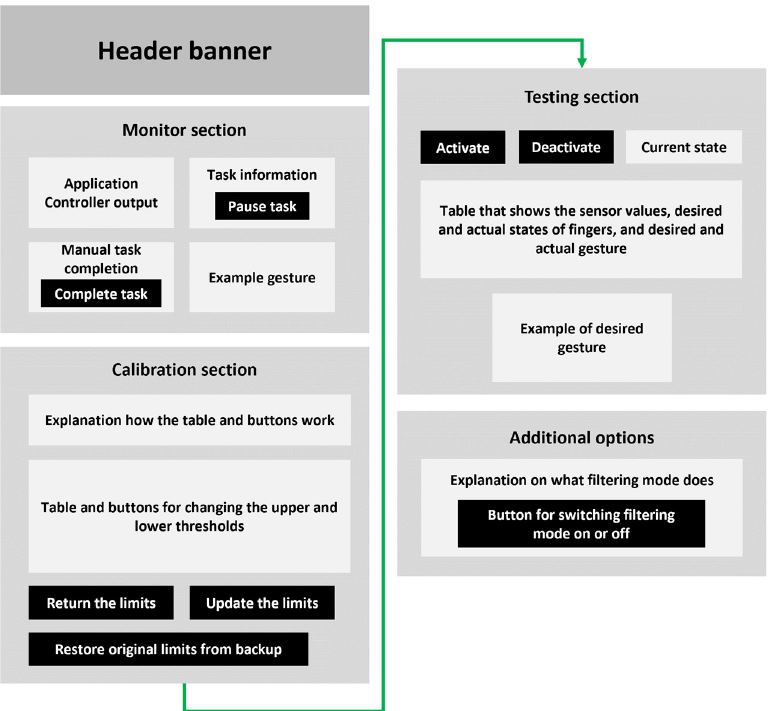
Figure 6. Wireframe of the UI developed for M2O2P component. The UI consists of three main sec- tions: monitor section for general information and task information, calibration section for calibrating the threshold values of the glove, and testing section for training and testing the gestures. Finally, additional options section holds a button to switch filtering by incoming tasks on or off. Since the UI is on one page, the continuation of the page is presented with green arrow.